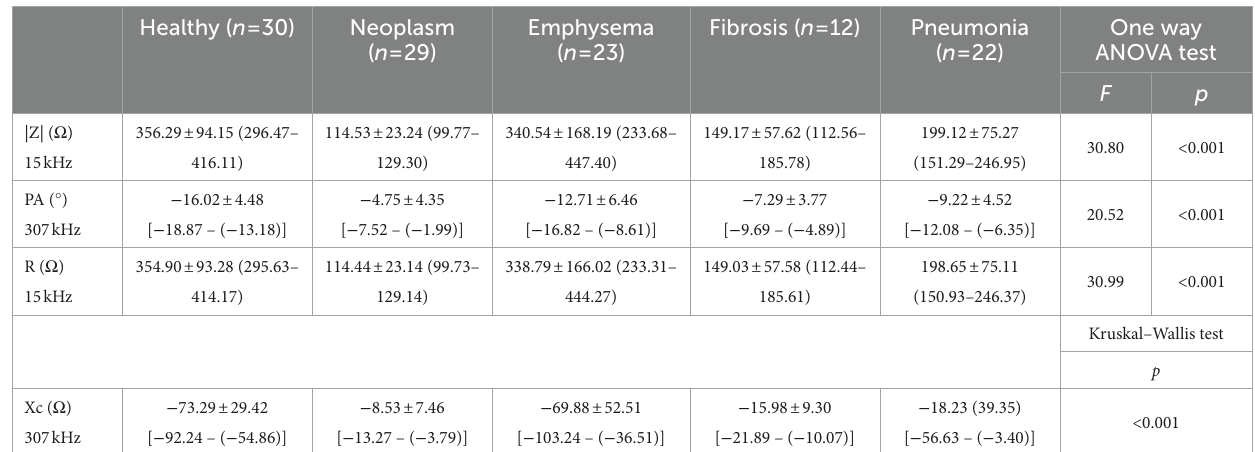
TABLE 1 Descriptions of minimally-invasive bioimpedance measurements for healthy lung tissue, neoplasm, emphysema, fibrosis and